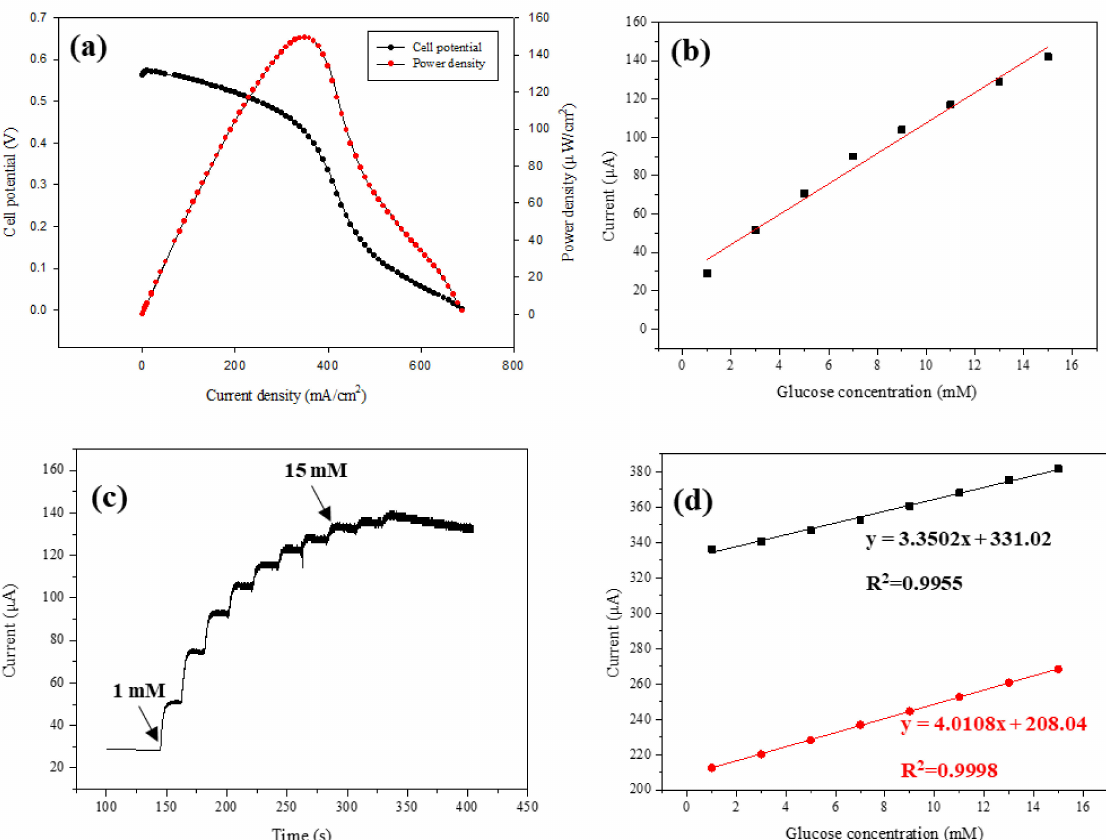
Figure 4. Biosensor capacity of the developed GO/Co/chitosan-based nano-biosensor. ( a ) Power output and cell potential versus current curves of the glucose oxidase modified electrode with GO/Co/chitosan at different external resistances compared with those of the bare electrode. ( a ) GO/Co/chitosan immobilized electrode. ( b ) Bare electrode; sensor capacity of the developed nano-biosensor. ( c ) Continuous real-time detection test. Inset of D-glucose detection at various concentrations (1.0~15.0 mM). ( d ) Stability test compared between the 1st and 14th day. Scan rate for D-glucose detection is from 10 to 100 mV · s − 1